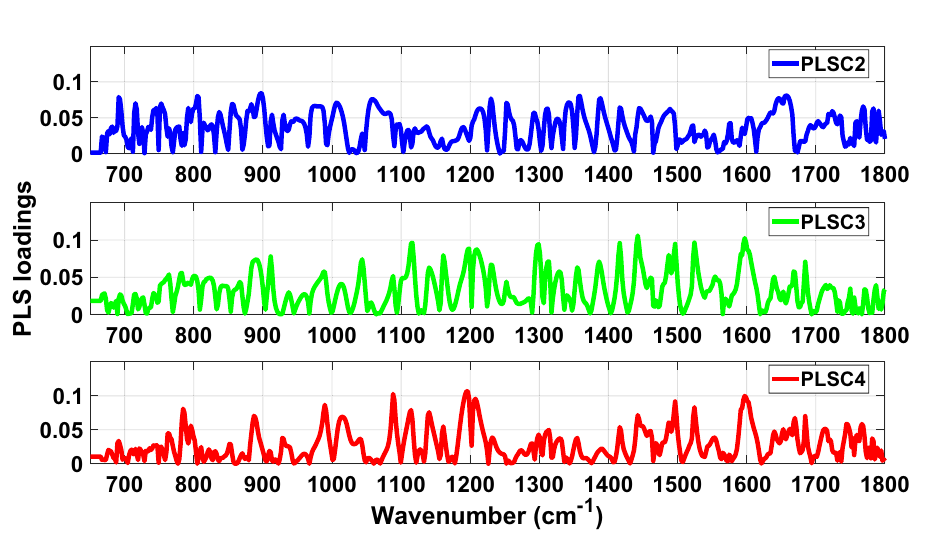
Figure 8. Absolute values of PLS loadings of PLSC2 (blue), PLSC3 (green) and PLSC4 (red) in the fingerprint spectral region between 650–1800 cm −1 for our analysis of the LIQUID 2